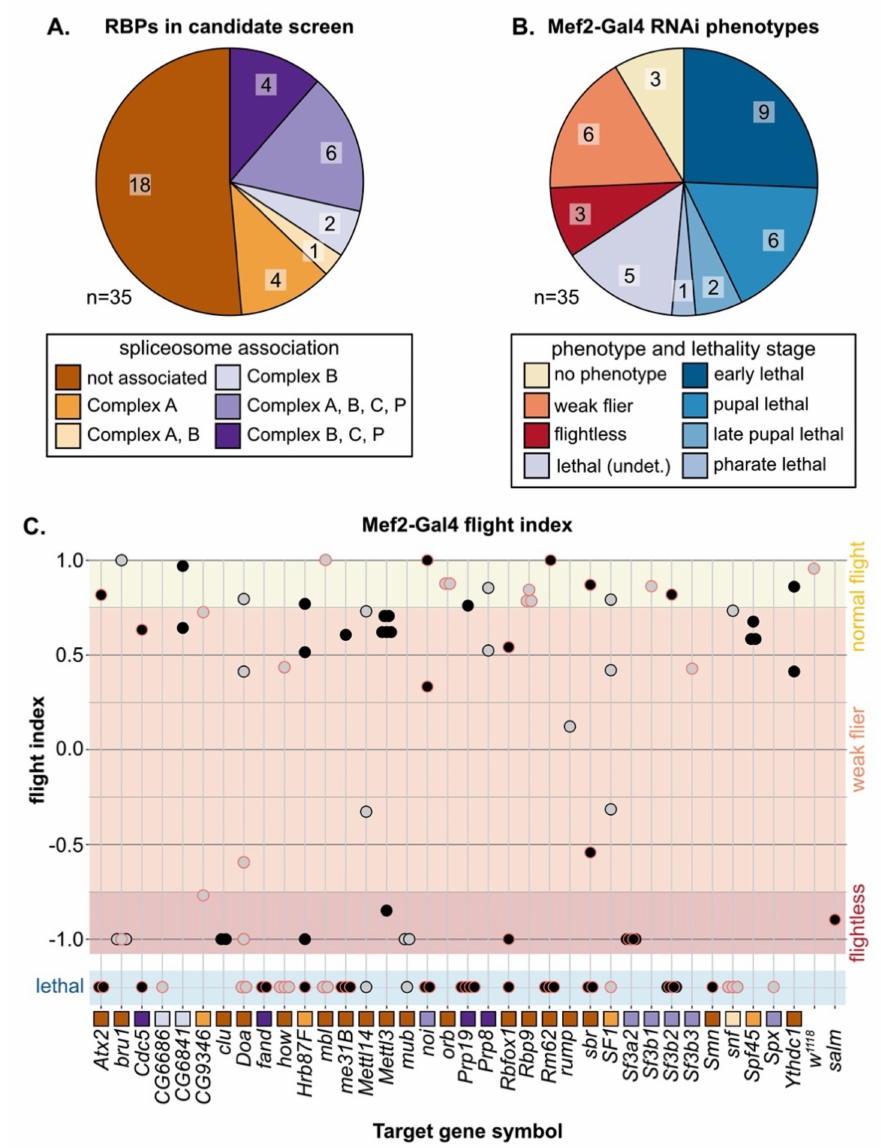
Figure 2. Muscle-specific RNAi knockdown candidate screen of 35 RBP genes. ( A ) Thirty-five RBPs were selected as candidates for further analysis in muscle, including 17 spliceosome asso- ciated genes. ( B ) Mef2-Gal4 knockdown lethality (blue shades) and flight (flightless, red; weak flier, orange) phenotypes for RBP genes based on the phenotype of the strongest RNAi hairpin. ( C) Plot summarizing Mef2-Gal4 phenotype for 105 hairpins targeting 35 RBP genes. Dots represent individual hairpins, and a red outline represents hairpins additionally tested with Act88F-Gal4 (Figure 4). Flight ability was classified as normal (yellow), weak/impaired (orange) or flightless (red). Lethal hairpins (blue) were not tested for flight ability. Hairpins are organized into columns by gene. Squares indicate spliceosome membership and are colored as in ( A